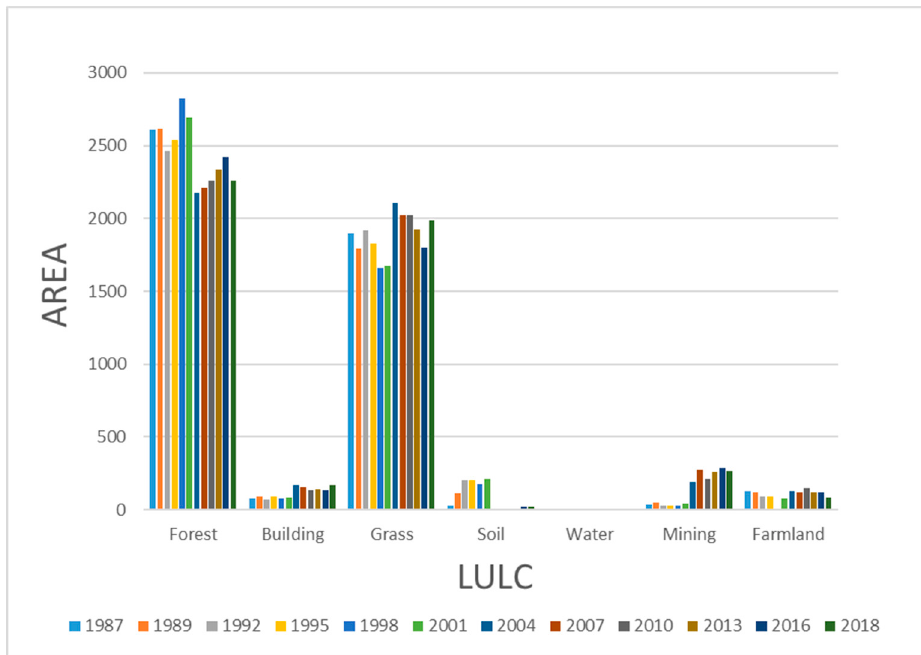
Figure 5. The total area of each LULC categories from 1987 to 2018 (Km 2 ).